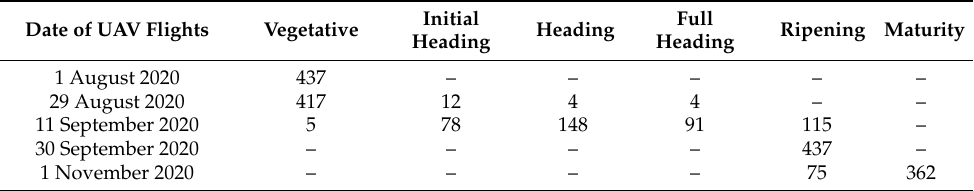
Table 1. Dates of the UAV flights and statistical numbers of plots in main phenological stages for